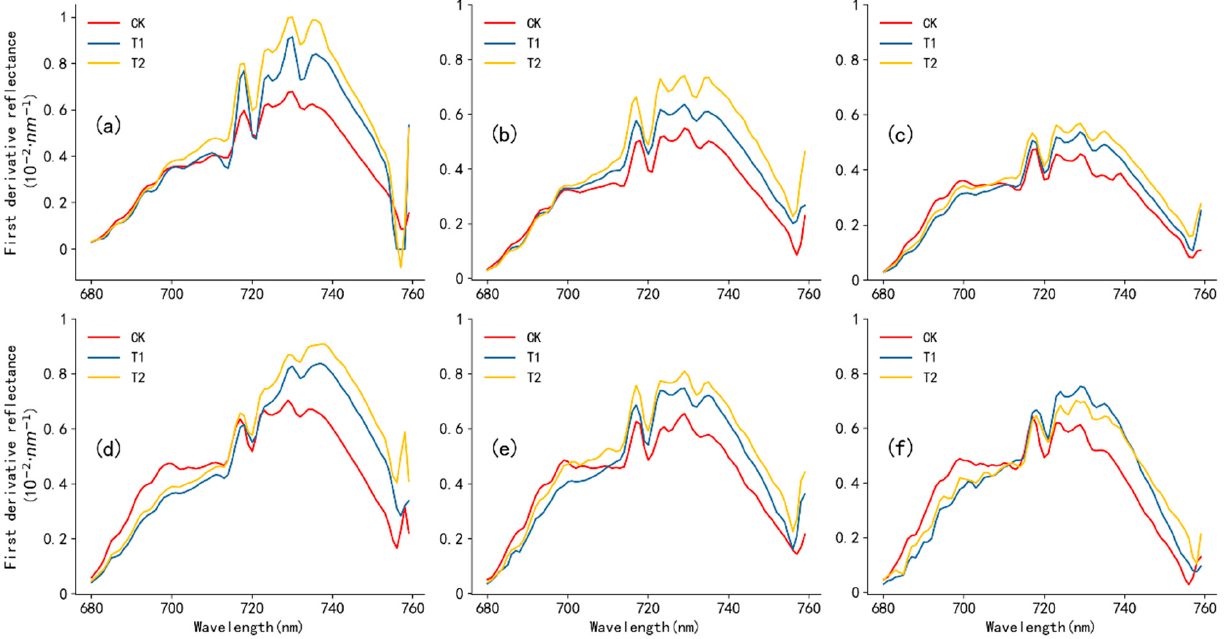
Figure 5. The first derivative spectra curve of the red edge with different treatments: ( a – c ) are DAH 14d, DAH 21d, and DAH 28d in 2016; ( d – f ) are DAH 14d, DAH 21d, and DAH 28d in 2017.